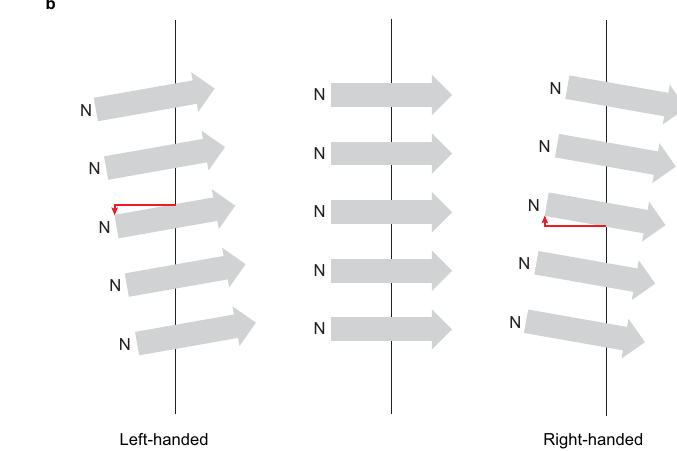
Fig. 5 | Orientation of the β -sheets relative to the fi bril z-axis. a Different tilt of residues Ser2-Asp33 of the vascular (green, stack B) and glomerular fi bril (cyan). The continuous line is parallel to the fi bril z -axis. The dotted line is drawn to guide the eye. Tyr29 (red) serves as a reference point. b Schematic representation of the